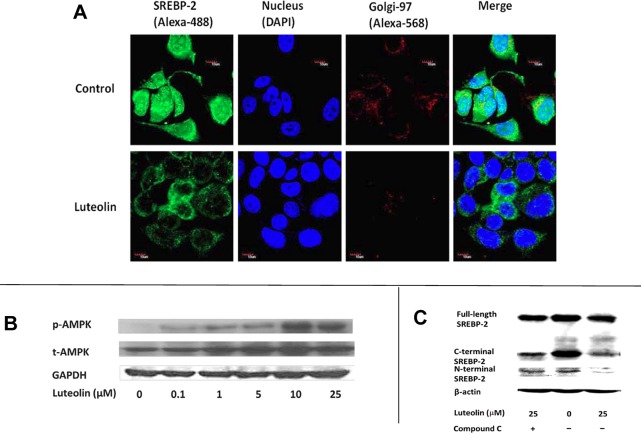
AMPK status and nuclear translocation of SREBP-2 in luteolin-treated WRL-68 cells.The hepatic cells WRL-68 were seeded onto 6-well culture plates and treated with luteolin at 10 μM. After 24 h of treatment, the cells were fixed and incubated with Golgi-specific and SREBP-2 primary antibodies and fluorophore (Alexa 568 and 488)-labeled secondary antibodies. The nuclei were counterstained with DAPI (Fig 6A). The images were obtained using confocal microscopy. In a separate experiment, the cultures were treated with various concentrations of luteolin and co-treated with the AMPK inhibitor Compound C. After 24 h of treatment, the cell lysates were immunoblotted for AMPK and SREBP-2. Images for AMPK and SREBP-2 are displayed in the lower left (Fig 6B) and right panels (Fig 6C), respectively. These results represent one of two independent experiments.